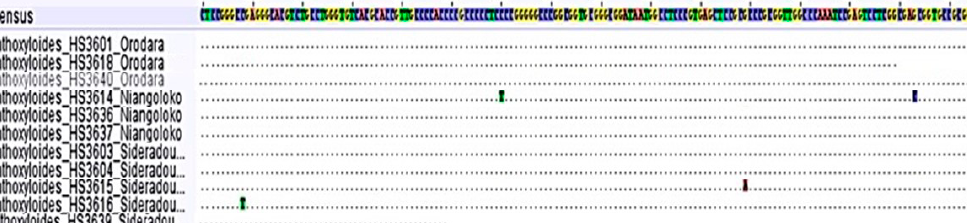
Figure 8. psbA-trnH alignment of Z. zanthoxyloides (partly).